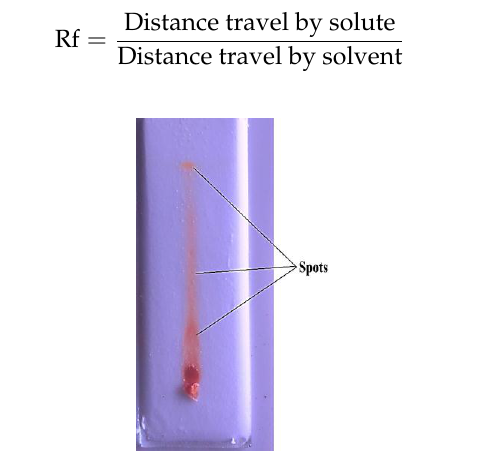
Figure 2. Thin layer chromatography of B. bassiana -28 extract. The mobile phases were chloroform: methanol in ratios of 10; 9:1; 8:2; 7:3; 6:4; 5:5; 4:6; 3:7; 2:8; 1:9; 10 and the retention factor (Rf) values of spots were 0.3333, 0.4444,